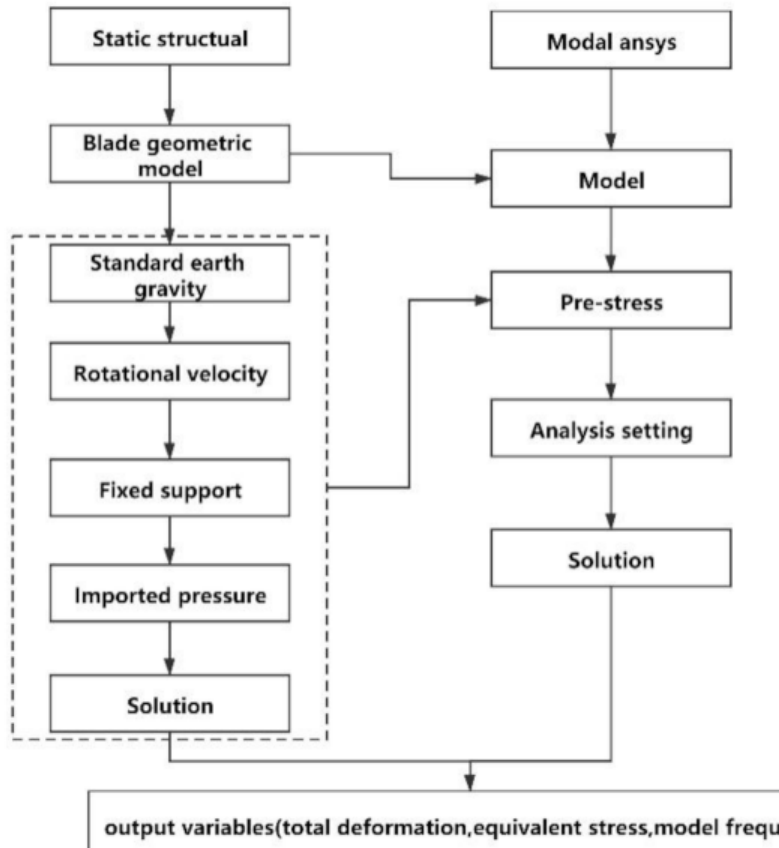
Figure 16. The flowchart of the modal